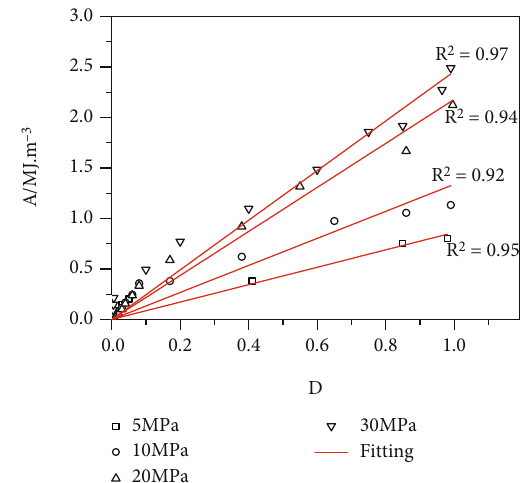
Figure 12: Relationship between damage dissipated energy and damage variable in cycle loading